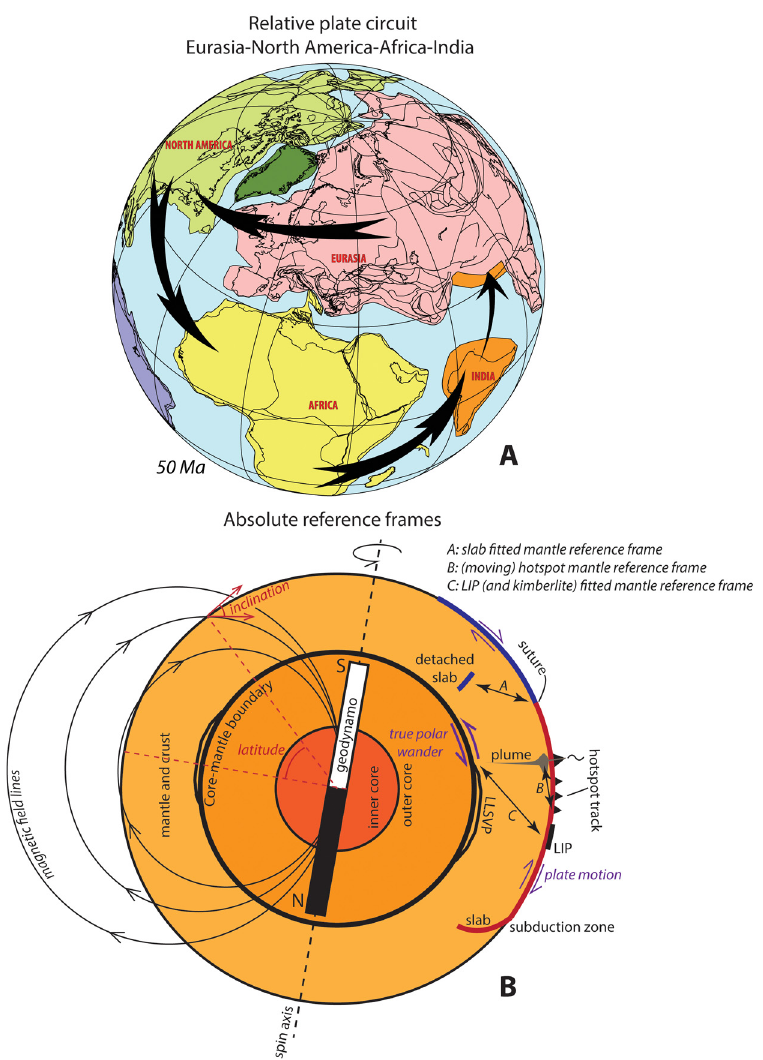
Fig 1. (A) Example of a plate circuit. The motion of India versus Eurasia cannot be directly constrained since these plates are bounded by a destructive plate boundary (trench). Relative motions between these